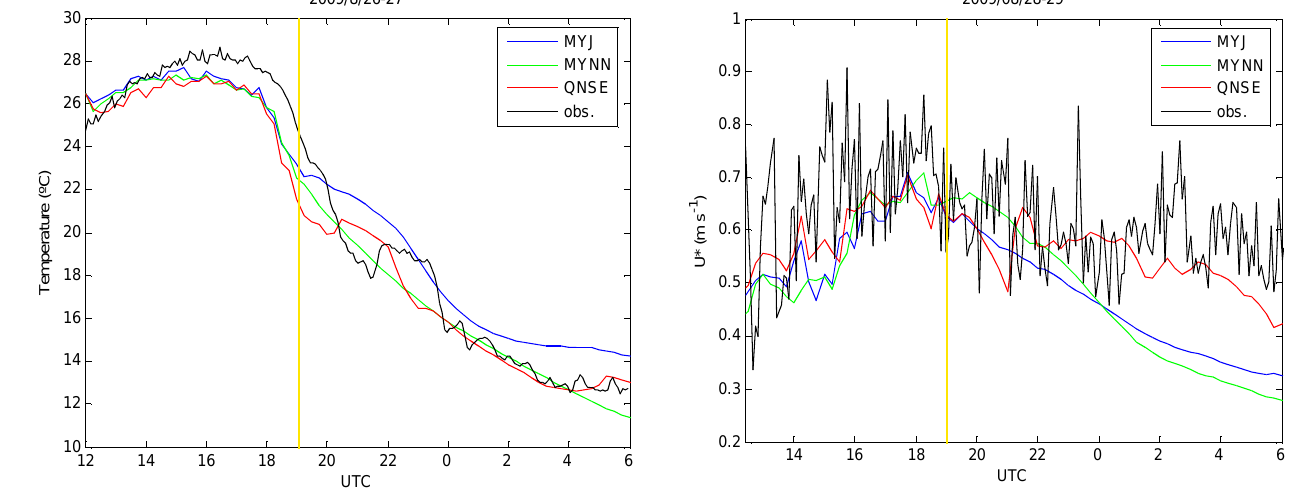
Figure 4. Simulations of 2m-air temperature and comparison with 5-min averaged observations for the 26–27 August 2009 transition (type C).